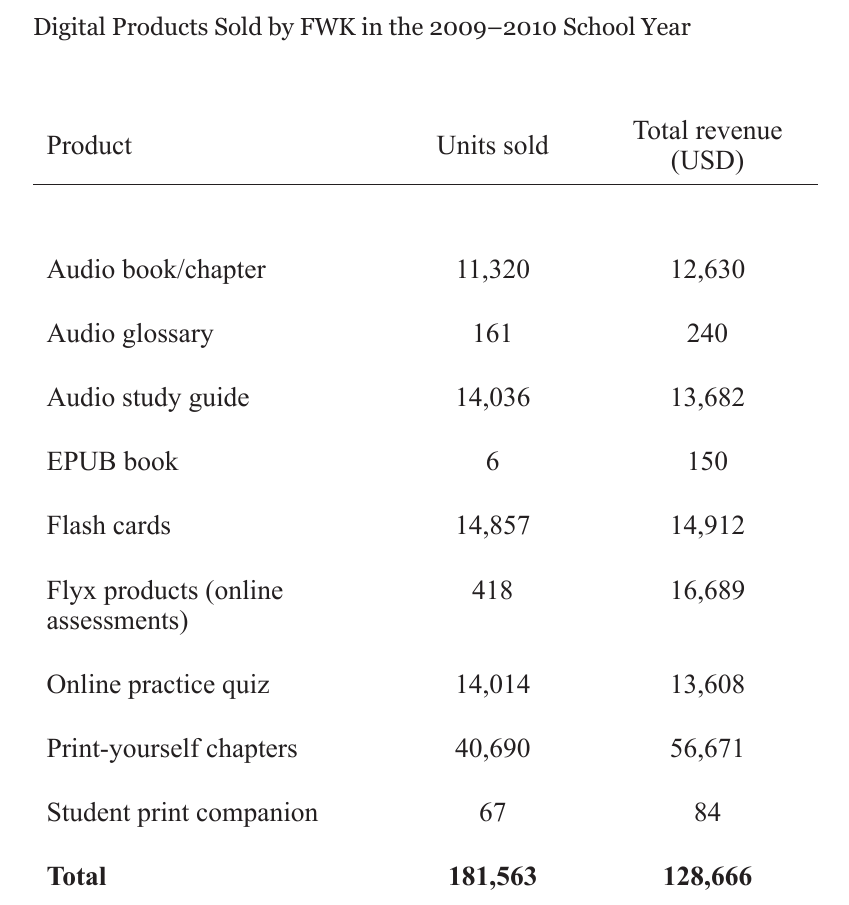
Table 2 Digital Products Sold by FWK in the 2009–2010 School